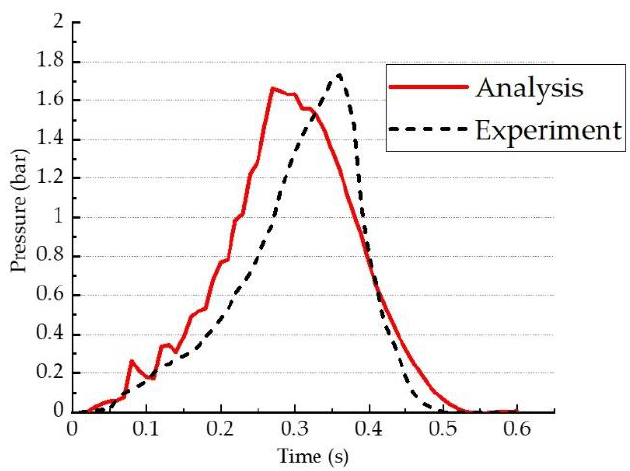
Figure 10. Explosion Analysis and Experiment Comparison in P1 point.